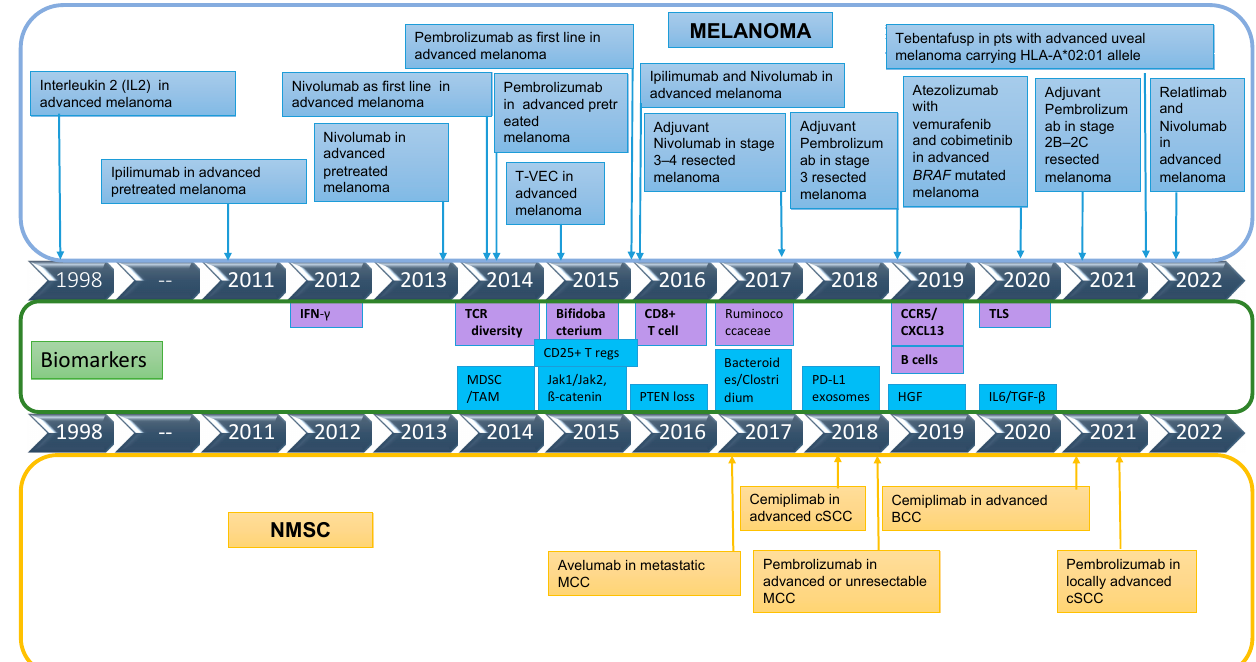
Figure 1. Timeline of immunotherapy agents’ approval for melanoma and non-melanoma skin cancer treatment. NMSC—non-melanoma skin cancer, cSCC—cutaneous squamous cell carcinoma, BCC—basal cell carcinoma, MCC—Merkel cell carcinoma, T-VEC—Talimogene laherparepvec; IFN- γ —interferon gamma; TCR—T cell receptor; CCR5—chemokine receptor 5; CXCL13—chemokine ligand 13; TLS—tertiary lymphoid structures; TAM—tumor-associated macrophages; MDSC—myeloid-derived suppressor cells; T regs—regulatory T cells; HGF—hepatocyte growth factor; IL6—interleukin 6; TGF- β —Transforming growth factor beta; purple colour for biomarkers: bi- omarkers of response; blue colour for biomarkers: biomarkers of resistance.